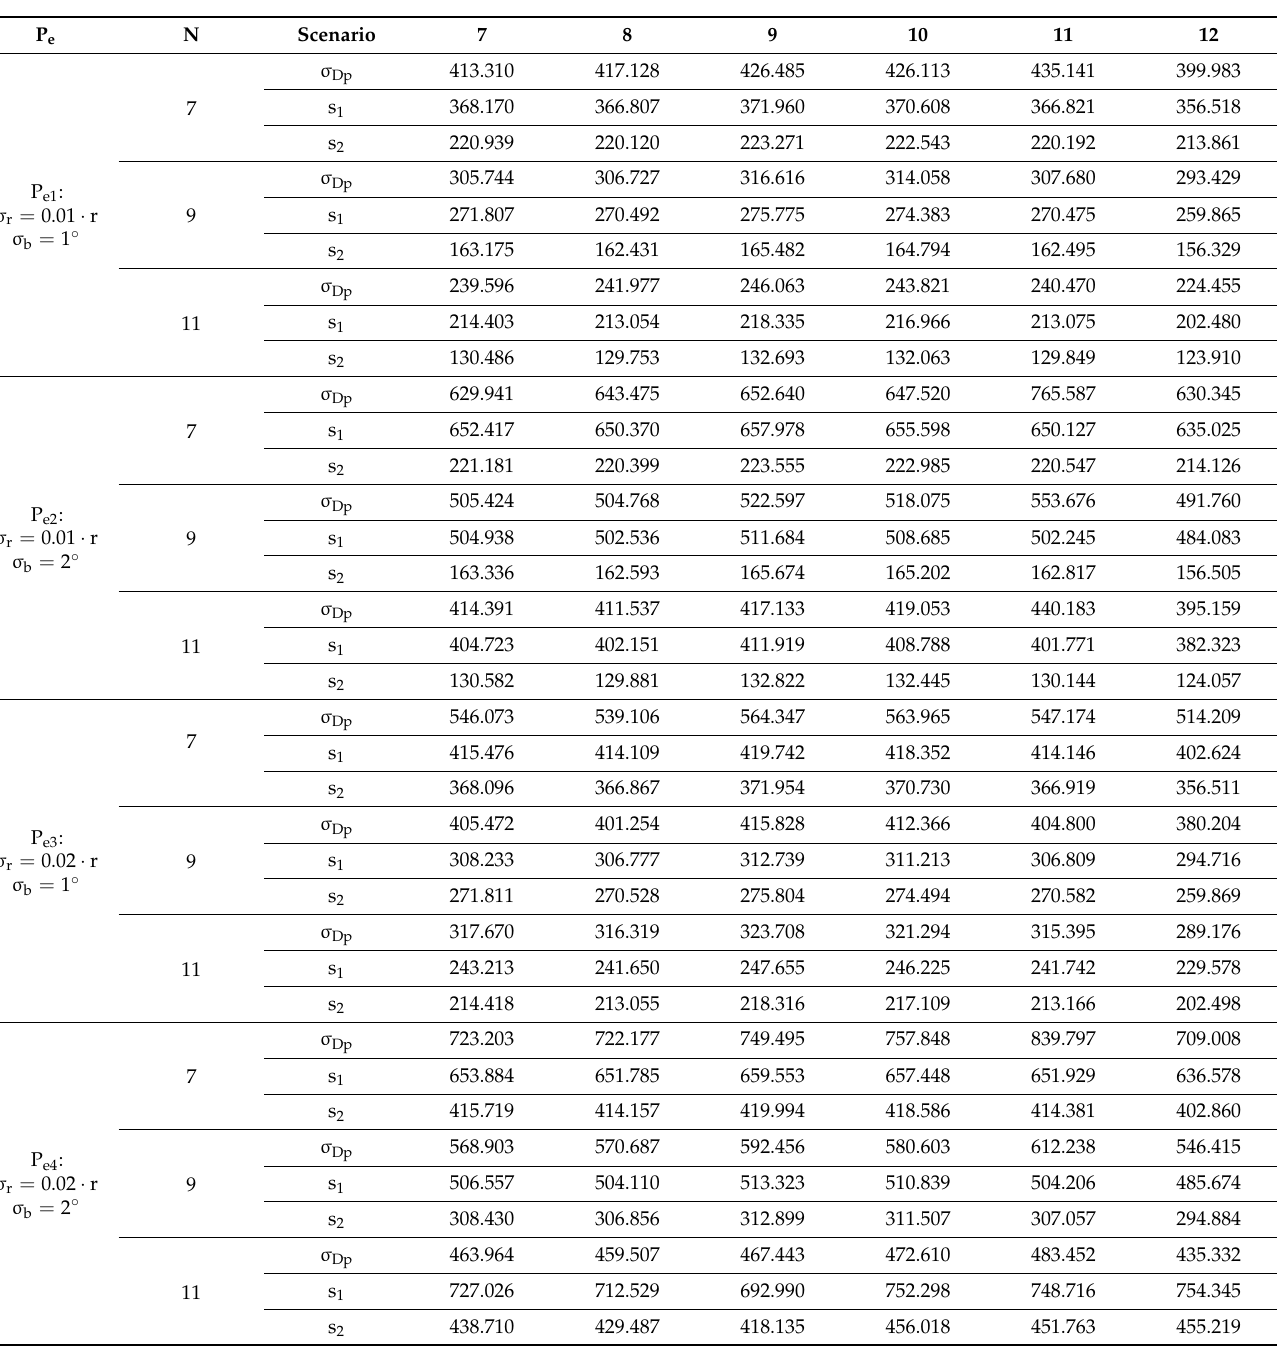
Table 3. RMSE of estimated position and AOU with different scenarios versus detection error values (long-range underwater